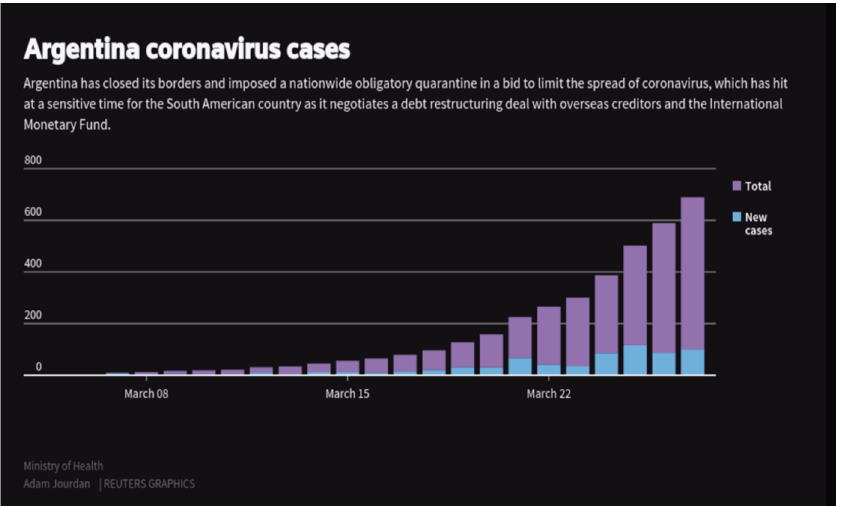
Figure 3. Graph of confirmed COVID-19 and new cases in Argentina from 8 March–22 March [23]. The Center for Disease Control and Prevention (CDC), issued a level 3 warning on